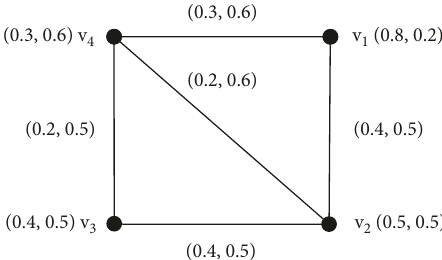
Figure 1: Intuitionistic fuzzy